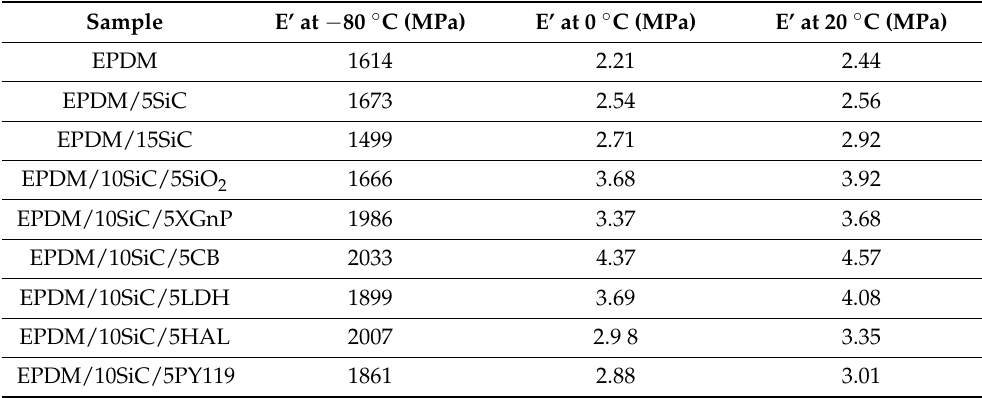
Table 4. Storage modulus at different temperatures for EPDM compounds in DMA